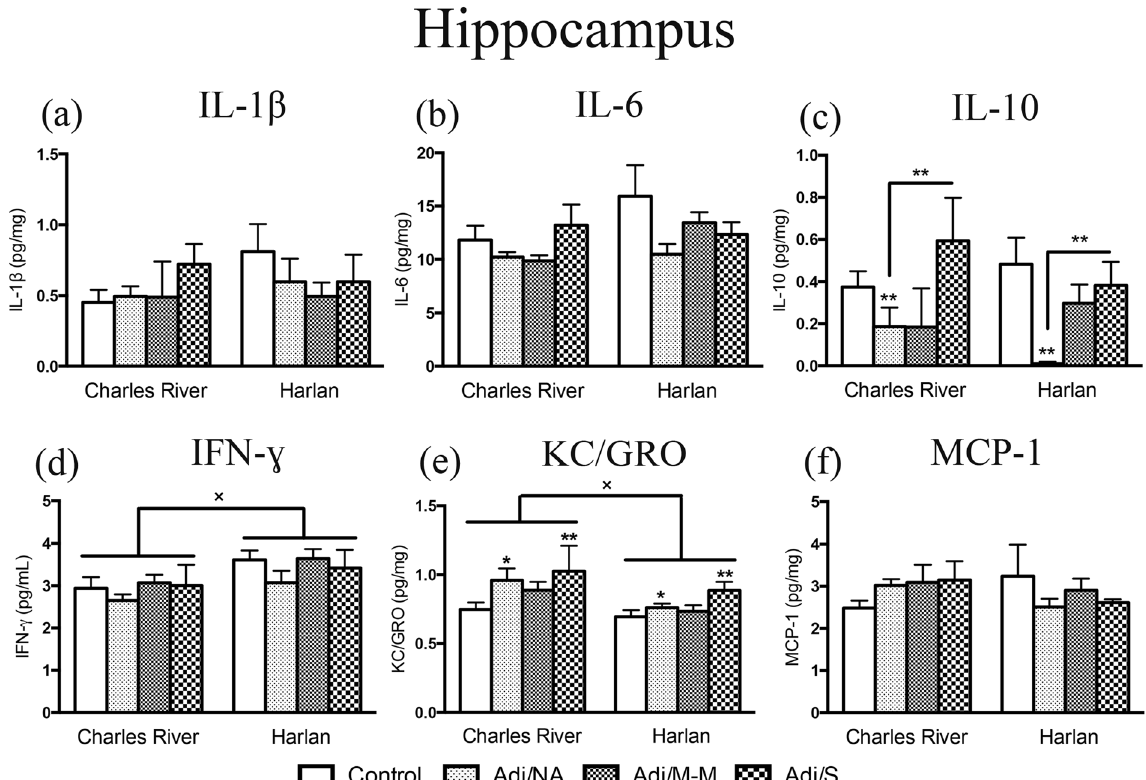
Figure 4. Cytokine levels in the hippocampus. Bars represent mean cytokine level ± SEM. Data are presented as pg cytokine/mg protein with statistical analysis conducted on Blom transformed (normalized) data. The presence of an asterisk ( * ) indicates a main effect of AA severity, with the comparison to the control group, unless otherwise indicated. The “ × ” symbol indicates a significant main effect of colony. Post hoc: * / × p < 0.05; ** p < 0.01. Control: saline-injected; Adj/NA: no clinical signs of AA following CFA injection; Adj/M-M: mild- moderate AA, clinical score ≥ 1, < 8; Adj/S: severe AA, clinical score ≥